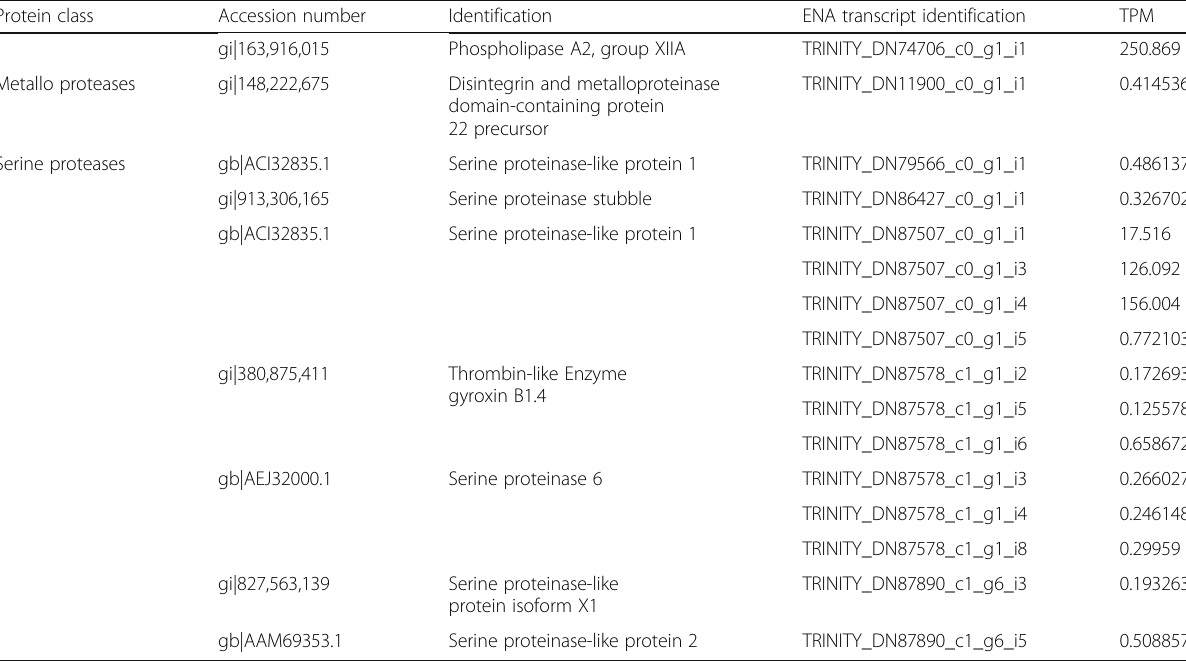
Table 3 List of other peptides and protein of interest from the transcriptome (Continued)